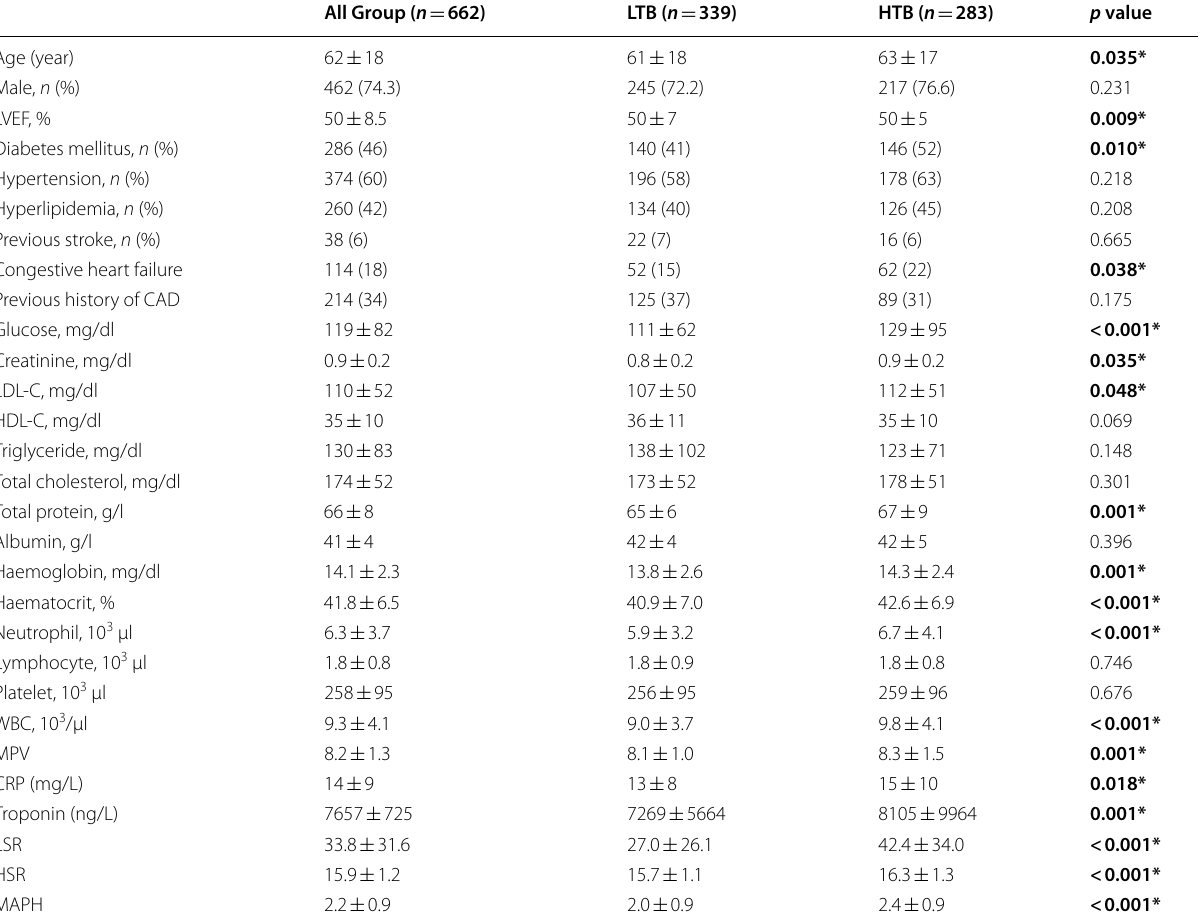
Data are presented as mean standard deviation for normal distribution or median interquartile range for not-distribution normality or n (%) ± ± LTB low thrombus burden; HTB high thrombus burden; LVEF left ventricular ejection fraction; CAD coronary artery disease; LDL-C low-density lipoprotein cholesterol; HDL-C high-density lipoprotein cholesterol; WBC white blood cell; CRP C-reactive protein; LSR low shear rate; HSR high shear